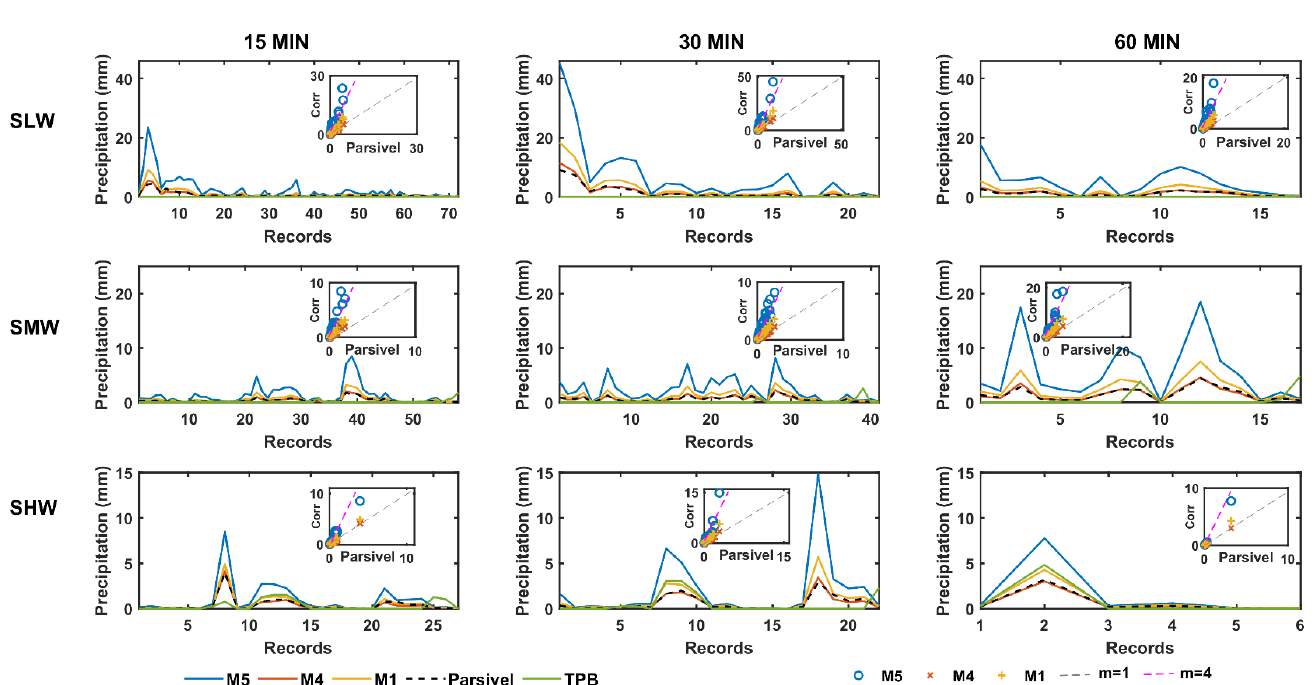
Figure 11. Measured values in disdrometer (black dashed line), and corrected solid precipitation according to density models 1 (M1 in yellow line), 4 (M4 in red line), and 5 (M5 in blue line) for low ( SLW ), medium ( SMW ) and high wind speed ( SHW ) groups for different time-scales (columns). The TPB values (green line) were included just for reference due to the limitations of this device prevent to measurement properly solid and unclassified precipitation. Scatterplots of M1, M4 and M5 respect to Parsivel were included. Dashed gray line and dashed light-purple line show m = 1 and m = 4 slopes, respectively. Table 9. Root mean square error ( RMSE ), relative difference ( Diff ), and accumulated ratio ( Ac r ) be- tween precipitation corrected with five density models and Parsivel measurements for three time- scales. Scores are displayed for low ( SLW ), moderate ( SMW ), and high wind speed ( SHW ) groups of solid precipitation.